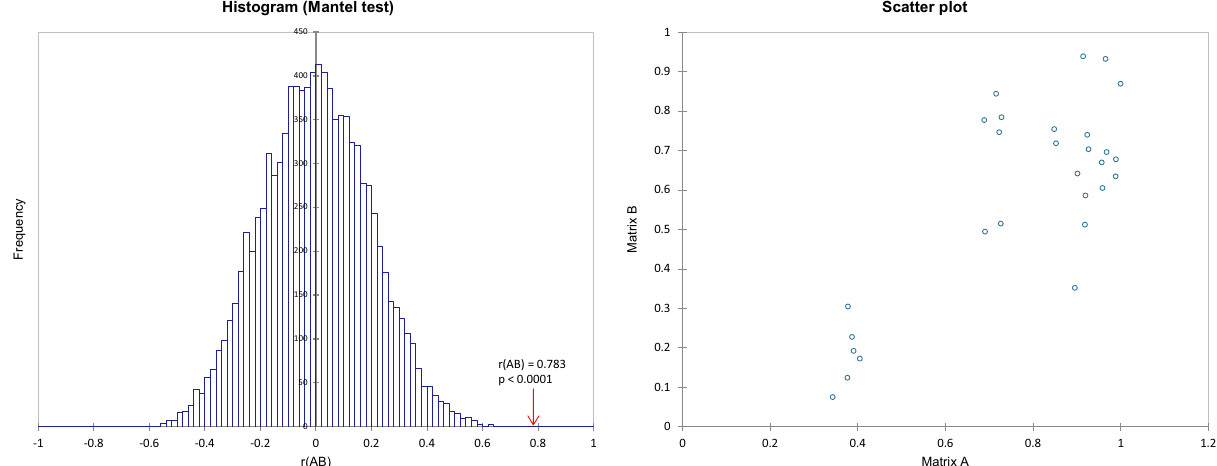
Figure 3. Mantel test for comparison of both correlation matrices (bacteria vs. fungi) using the Monte Carlo